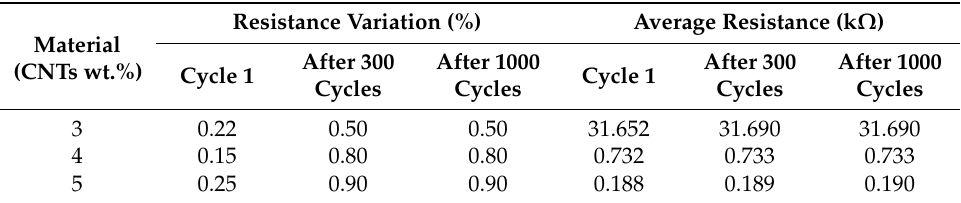
Table 2. Resistance variation occurring during a single cycle of deformation and the average resistance value of a portion of the bar 40 mm long (displacement of up to 1.5 mm, displacement speed: 50 mm/min) after increasing the number of cycles.